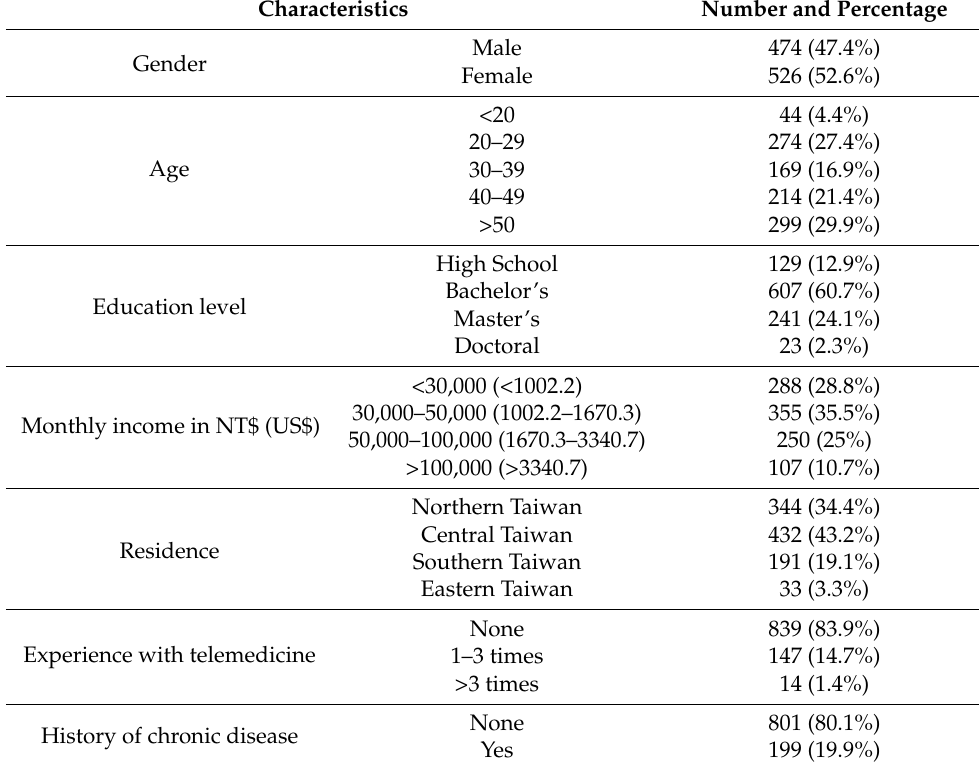
Table 2. Sample demographics of 1000 respondents.